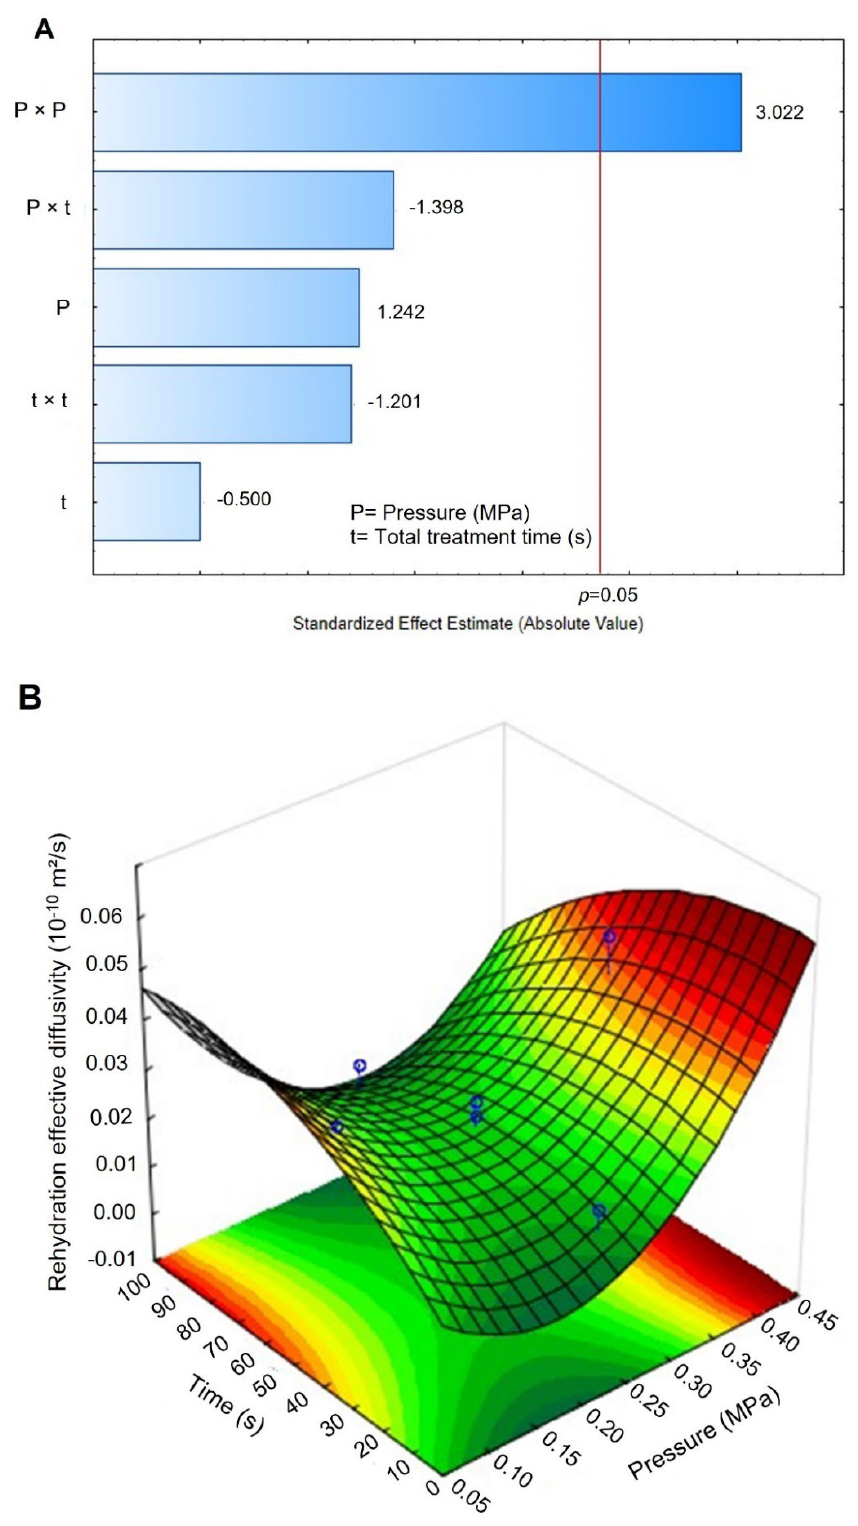
Figure 7. Effects of Pressure (MPa) and time (s) of DIC treatment on the rehydration effective diffusivity (10 − 10 m 2 /s) in maize kernels. ( A ) Pareto Chart and ( B ) surface response and fitting model. D eff-rehy = 0.0202 − 0.230P + 0.664P 2 + 0.00071t − 0.0000037t 2 − 0.001509P × t .